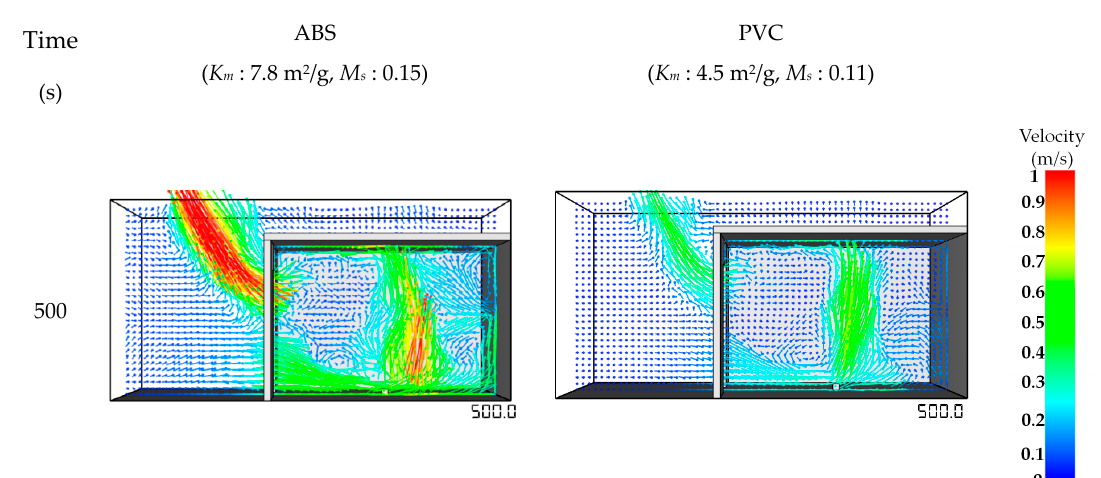
Figure 9. Calculated flow field at 500 s after ignition.